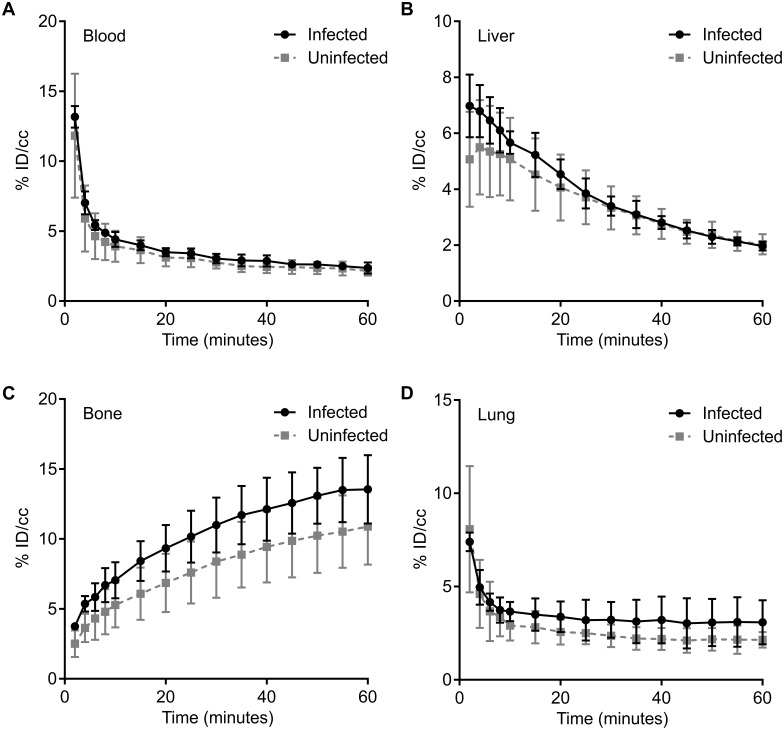
Organ compartment pharmacokinetics of 5-[18F]F-PZA.After a single intravenous injection of 5-[18F]F-PZA, a dynamic PET was acquired over 60 min and biodistribution data was calculated for blood (A), liver (B), bone (C) and lungs (D). No significant difference between the concentration of 5-[18F]F-PZA in infected and uninfected animal tissues was observed. Data are represented as mean and standard deviation of the percent injected dose per volume (%ID/cc). Three animals were used for each group.